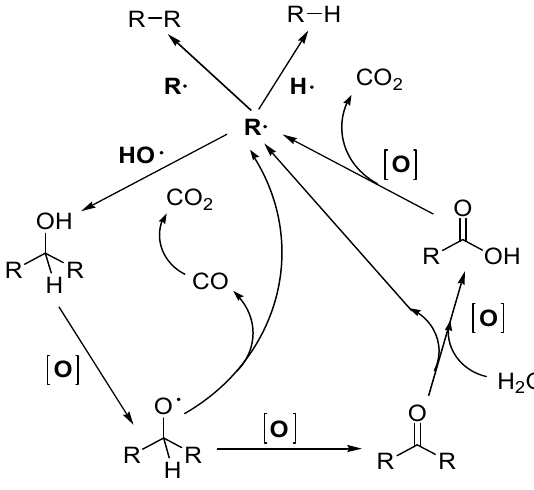
Figure 5. General proposed mechanisms of oxygenates PR (oxidative pathway).